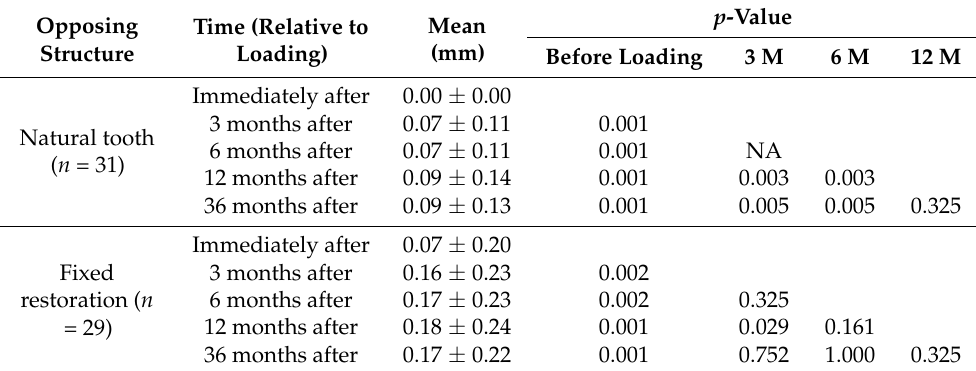
Table 3. Analysis of changes in marginal bone level with natural teeth and fixed restorations in the opposing arch of the submerged dental implants.